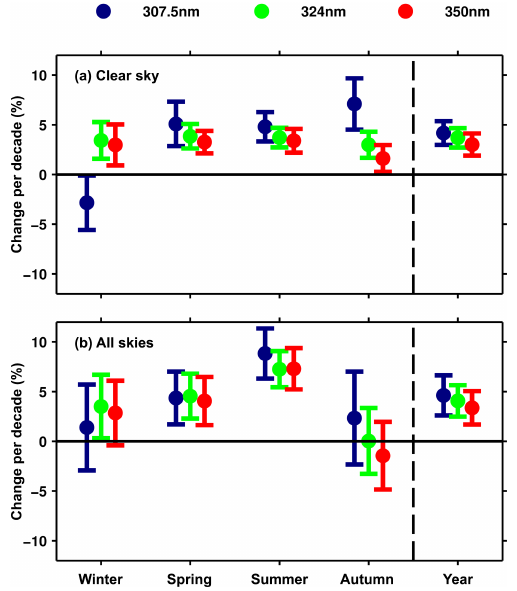
Figure 3. Long-term changes (in % per decade) and associated 1 σ uncertainty of the seasonal and the yearly mean spectral irradiance for 307.5, 324 and 350nm at 64 ◦ SZA, for clear-skies (a) and all- skies (b) at